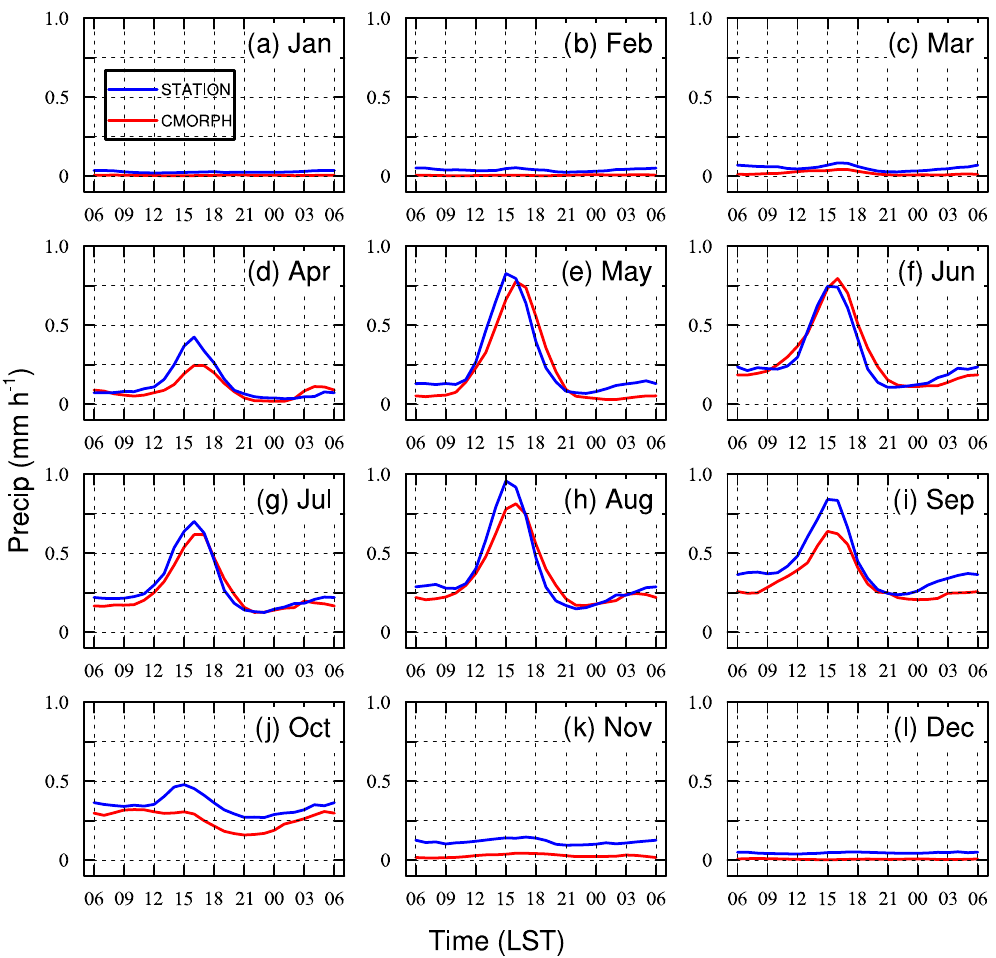
Figure 3. Average station rainfall accumulations obtained from gauges (blue) and CMORPH (red) in each